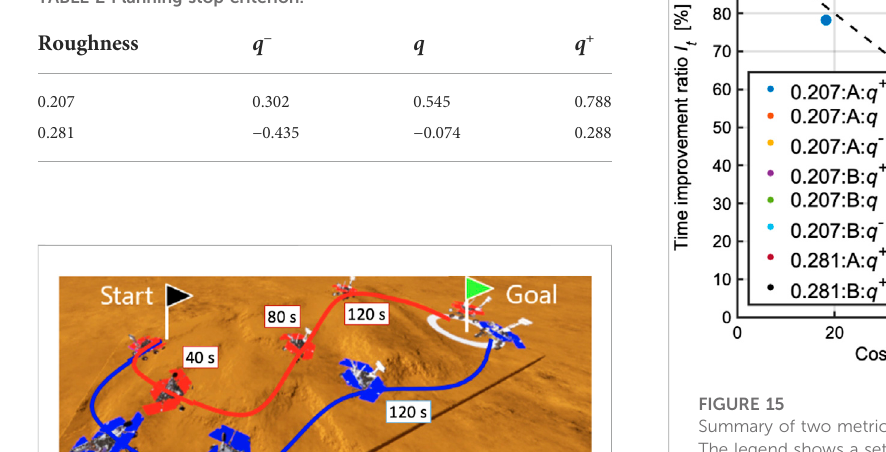
TABLE 2 Planning stop criterion.